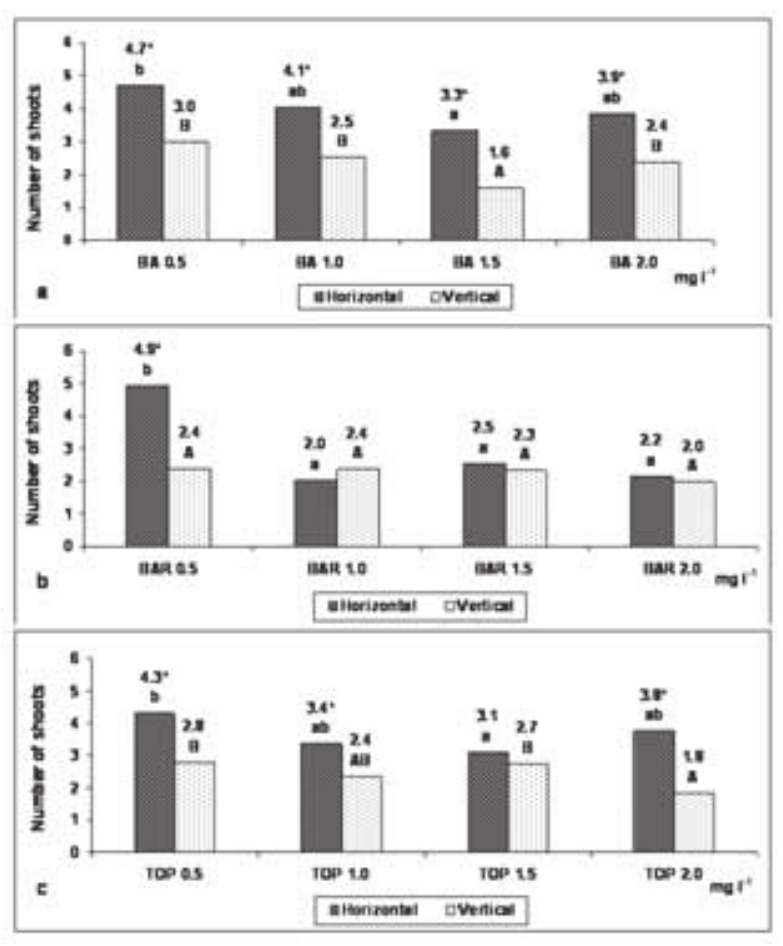
Fig. 1. The effects of explant positions and cytokinin concentrations on the multiplication rate of Asparagus offi cinalis ’Grolim’. Signifi cant differences (P<0.05) between different explant positions are indicated by * at the same cytokinin treatment. Signifi cant differences (P<0.05) between different cytokinin concentrations are indicated by small letters in the case of horizon- tal position of explants and by capital letters in the case of vertical position of